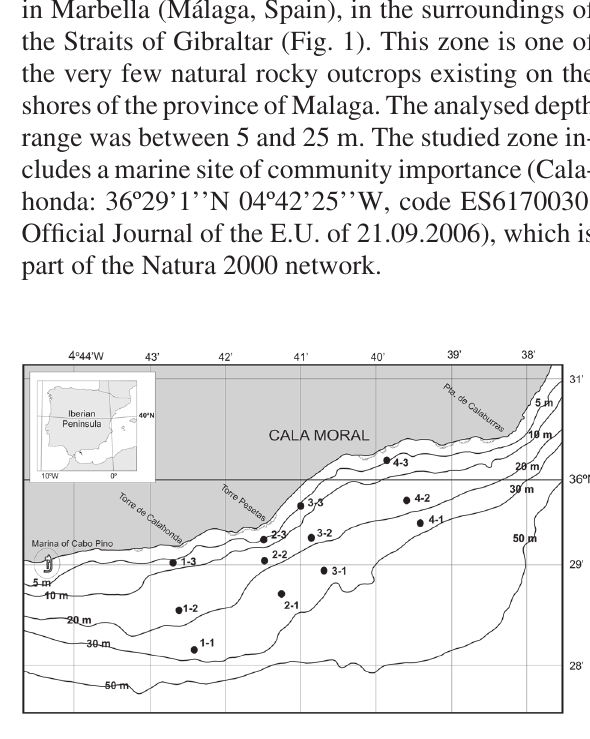
Fig . 1. – Study area and sampling